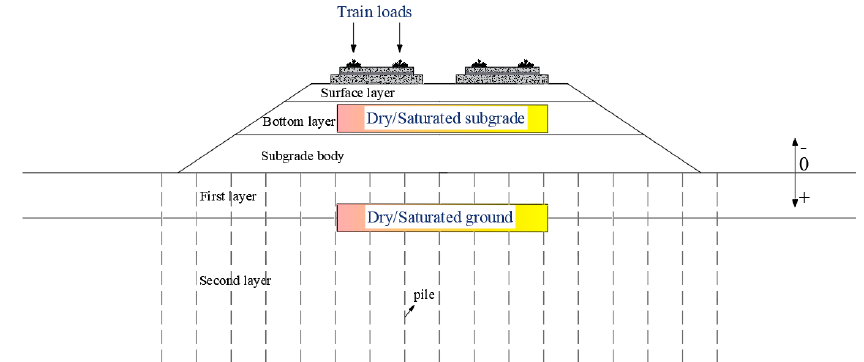
Figure 11. Multi-layered soils.